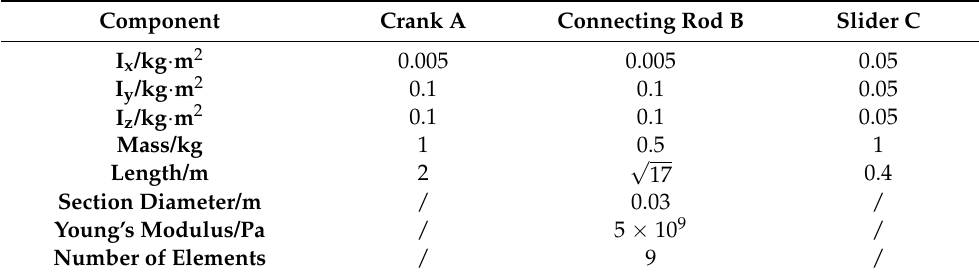
Table 1. Mechanism parameter.